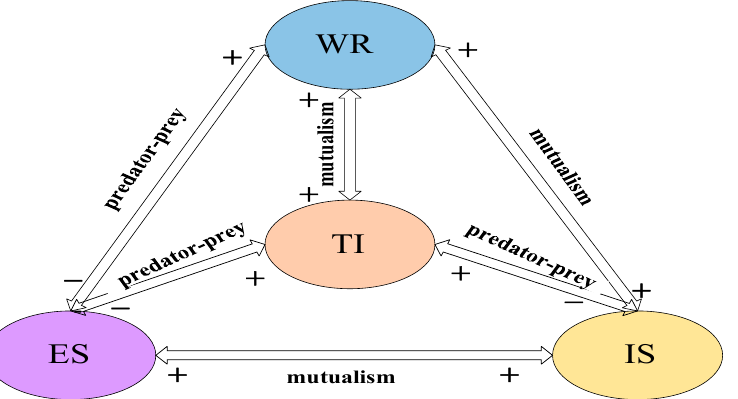
Figure 4. The relationship between Water Resources System-Economy System-Industrial System- Technology Innovation System in Beijing.